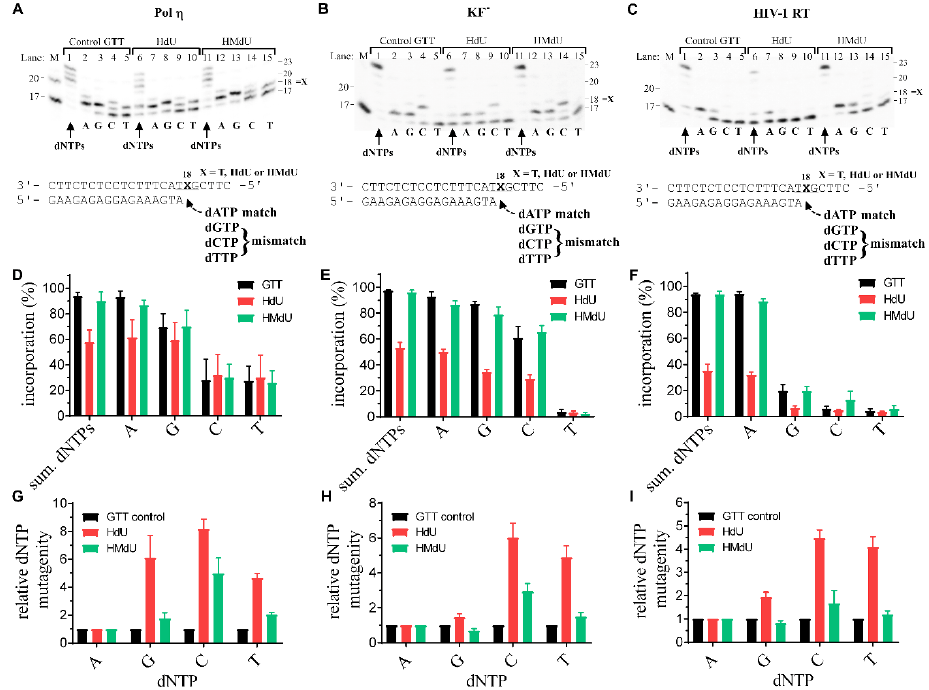
Figure 4. The replication fidelity of pol η , KF – , and HIV-1 RT. The capacity to elongate a 5′ - 32 P-labeled 17mer primer annealed to the unmodified 23mer templates (panels A , B , C , lanes 1–5) or to the 23mer templates containing HdU or HMdU thymine derivatives, respectively, as depicted in panels A , B , C in lanes 6 – 10 or 11 – 15, respectively (the corresponding nucleotides in these templates are marked by bold letters at the bottom of gels) in the presence of all four deoxyribonucleotide 5`-triphosphates (dNTPs) or complementary dATP or non-complementary nucleotides individually. Lane M: DNA markers. The newly synthesized DNA products were resolved by denaturing 15% PAA gel electrophoresis and visualized by radiography. The amount of synthesis was defined as the amount of radioactivity corresponding to the products of incorporation, (18 – 23) nucleotides long, on the 5 ’ side of the template strand and beyond divided by the total radioactivity in the respective lane (panels D, E, F) for each thymine derivative. Relative dNTP mutagenicity (panels G , H , I ) was calculated as a ratio of the respective misincorporation frequency f = ( K cat /K m ) incorrect /( K cat /K m ) correct for the oligonucleotides with thymine derivatives and control oligonucleotide with thymine. Data are means (±SD) from three different experiments.